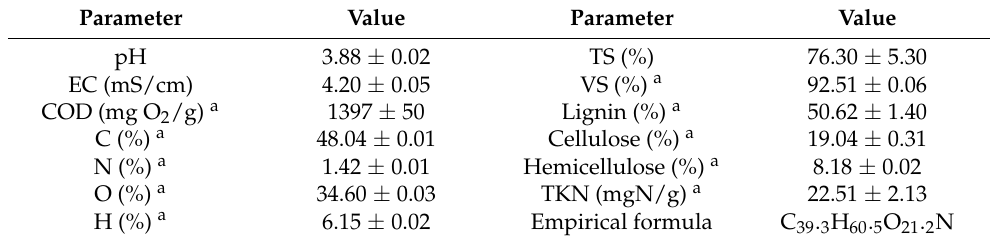
Table 1. Properties of grape pomace tested in the present study.